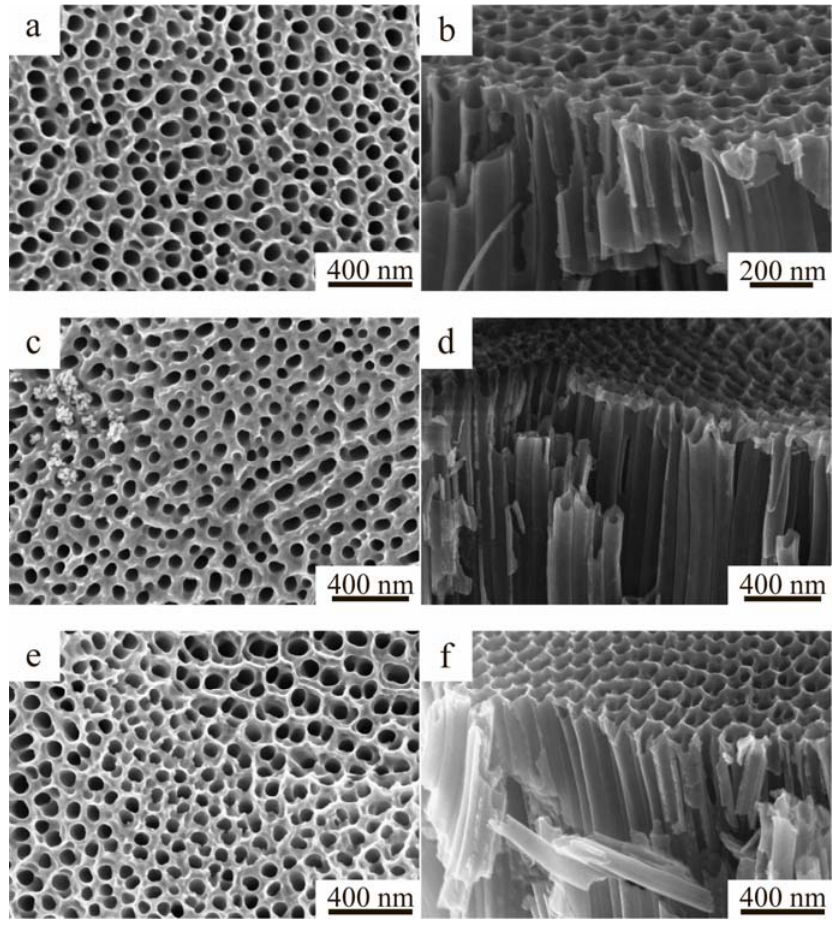
Figure 1. SEM images of the surface and chips of the obtained samples: ( a , b ) TiO 2 NTs, ( c , d ) TiO 2 NTs-S-Air, ( e , f ) TiO 2 NTs-S-Arg. NTs-S-Air, ( e , f ) TiO 2